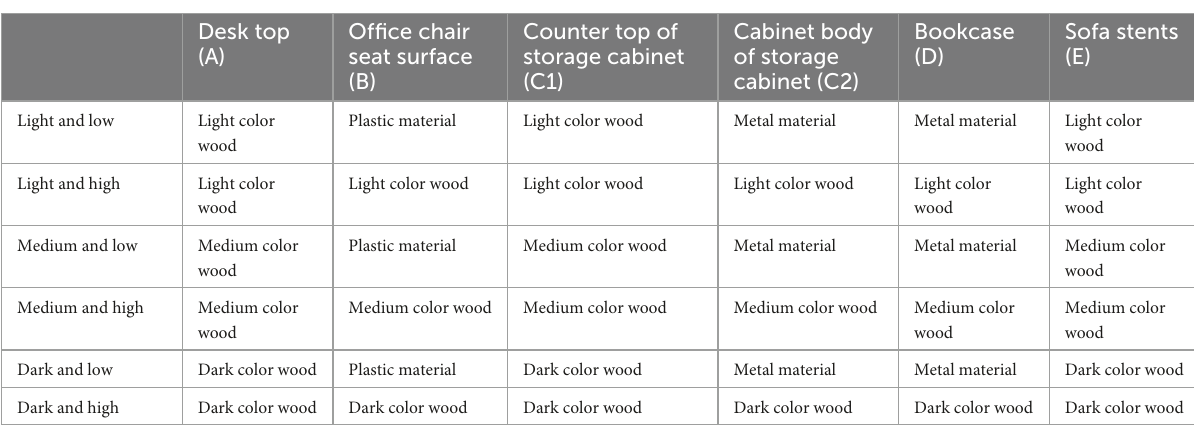
TABLE 1 Wood colors and wood areas in office space. Desk top